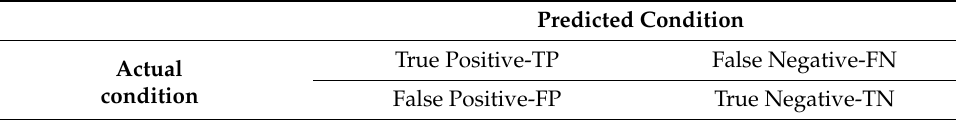
Table 4. Confusion